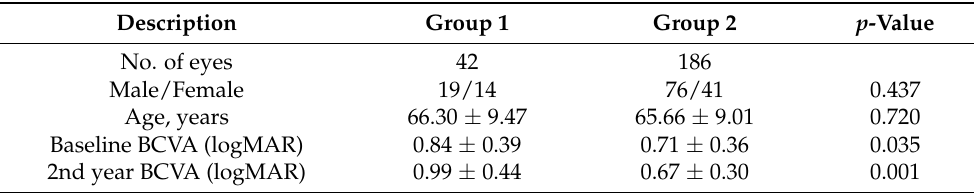
Table 1. Demographic and clinical properties of the